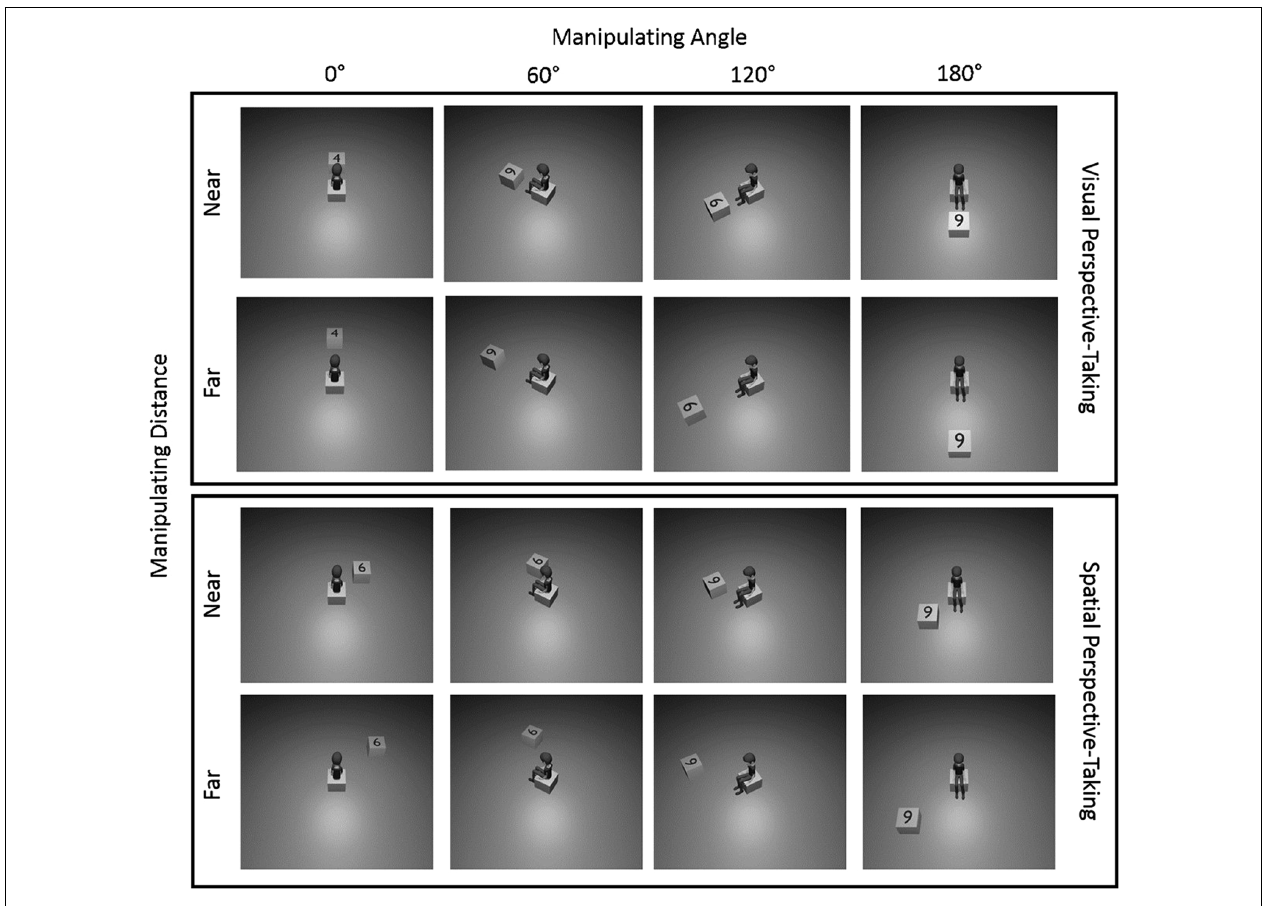
FIGURE 1 | Example stimuli from Experiment 1. Here all examples show anticlockwise rotation. An equal number of stimuli showed clockwise rotations.The Visual perspective-taking condition also included stimuli in which the block/number was located behind the